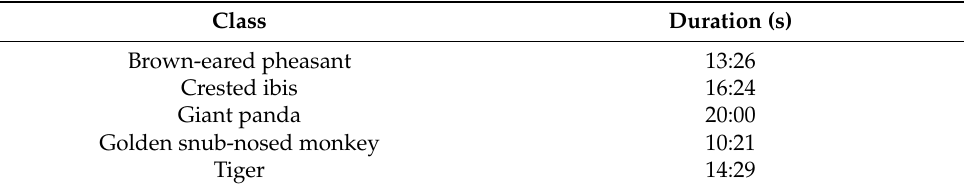
Table 1. Detail of MOT-EA dataset.